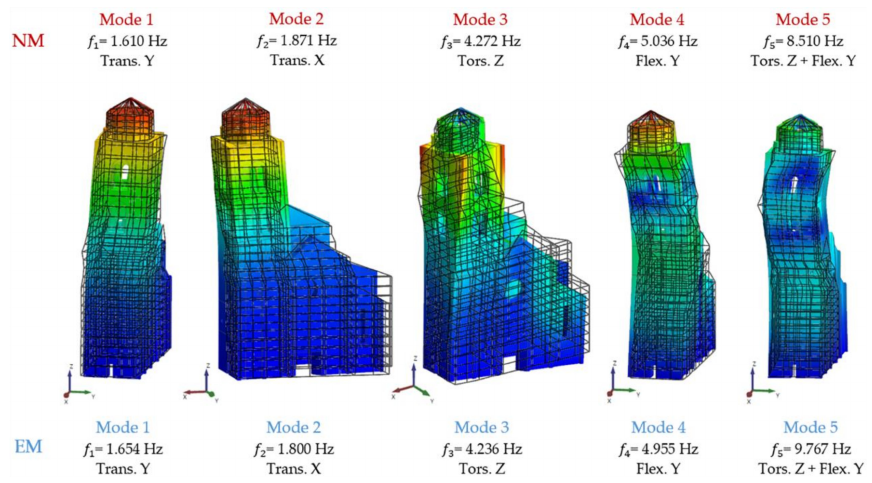
Figure 8. Comparison between the Numerical Model (NM) and Experimental Model (EM) mode shapes at step 2.